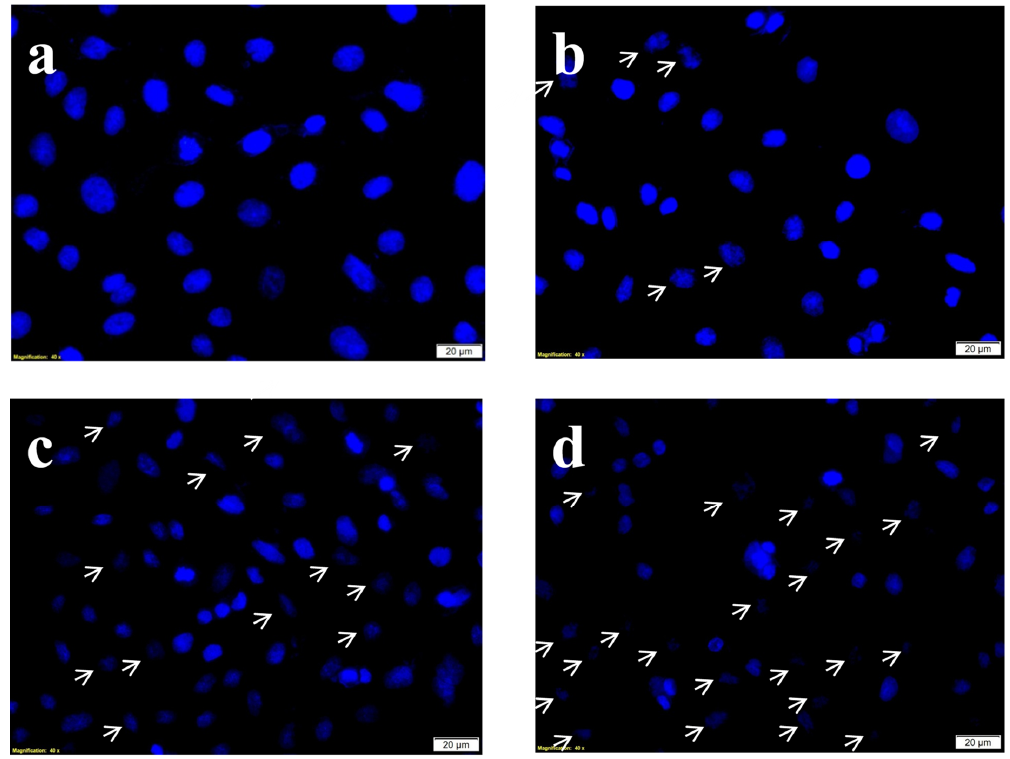
Figure 7. E ff ects of CA and PDT on nuclear DNA damage of A549 cells by DNA-specific Hoechst stain. Where, ( a ) group 1 (Control), untreated cells; ( b ) group 2, laser control (5 J / cm 2 ); ( c ) group 3 (PDT), PS (15 µ M) + laser (5 J / cm 2 ); ( d ) group 4 (Phyto-PDT), CA (52 µ M) + PS (15 µ M) + laser (5 J / cm 2 )